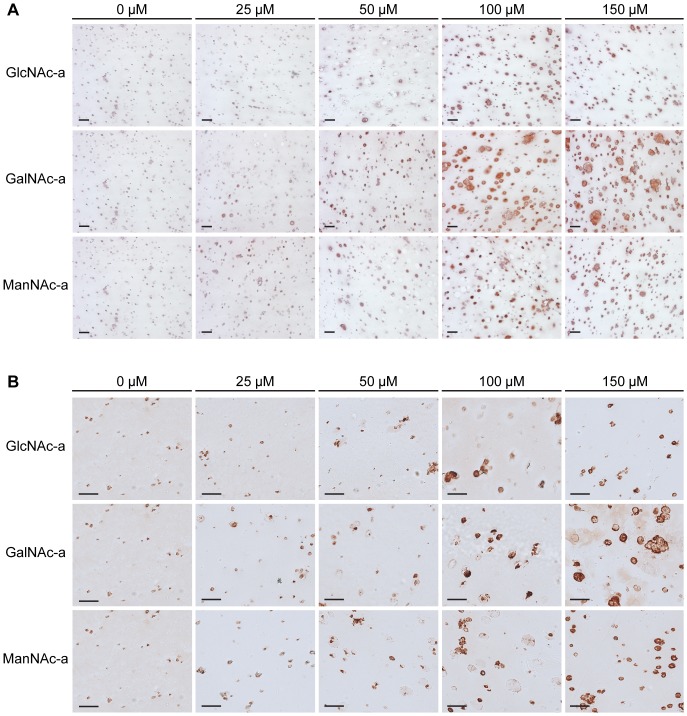
Histological analysis of IL-1β-stimulated chondrocytes exposed to hexosamine analogs in 3D hydrogels.(A) Safranin-O staining for proteoglycans and (B) type II collagen immunostaining (scale bar: 50 µm).